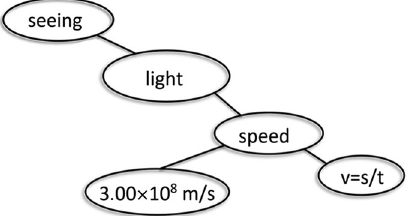
FIG. 1. The light concept map to support students talking about the basics of seeing and the speed of light.